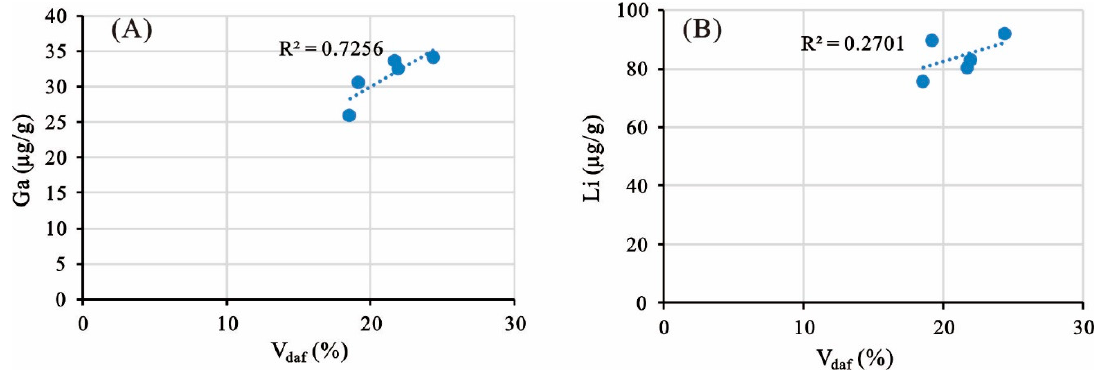
Figure 20. Plots of the amount of volatile matter versus ( A ) Ga, and ( B ) Li for the No. 5 − 2 coals from Dongpo Mine.